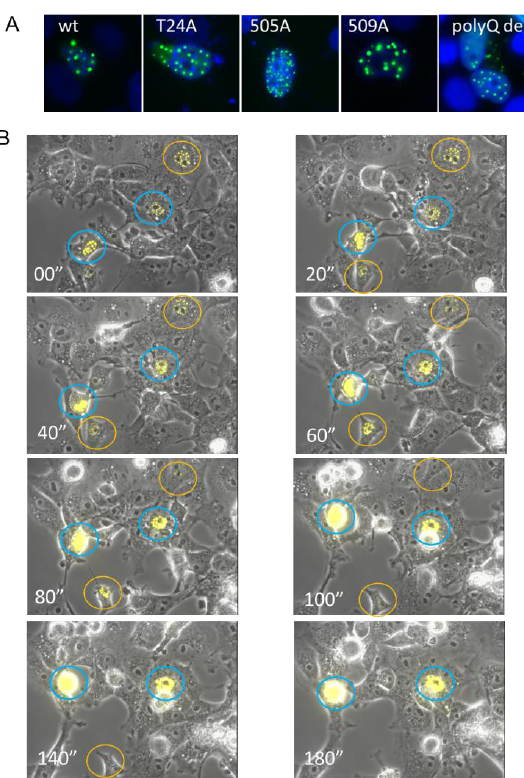
Figure 3. Overexpressed SRC-3 rapidly forms nuclear aggregates. ( A ) GFP imaging of MCF-7 cells 72 h post-transfection with wtSRC-3, three different SRC-3-GFP phospho-mutants, and SRC-3 deleted for the polyQ region (residues 1230 – 1300). 63 × magnification ( B ) Still images from video-microscopy of aggregation of YFP-SRC-3 in transfected cells. MCF-7 cells were transfected with YFP-SRC-3 and microscopy was performed 24 h later on an Axiovert 200M inverted fluorescent microscope (Carl Zeiss, Toronto, ON, Canada) for a total of 24 using Axiovision 4.8 acquisition software (Carl Zeiss). Images were acquired using a 10 × objective (EC Plan-Neofluar) with a side-mounted AxiocamHRm camera (Carl Zeiss). YFP was excited using the Colibri LED illumination system (LEDmodule 505nm, Carl Zeiss) and detected using the 46HEYFP filter (Carl Zeiss). Exposure times were 1 ms (brightfield/phase contrast) and 100ms (YFP) at 10 min intervals for 24 h and compiled into video files using Axiovision 4.8 software (Carl Zeiss). 20 min intervals are shown. Cells circled in blue showed continuous accumulation of SRC-3 while cells circled in orange appeared to resolve aggregates.